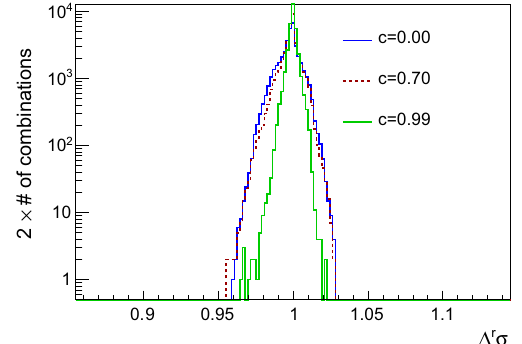
Fig. 4 Difference between the combined result ¯ x obtained with the methodproposedhereandusingadirectlikelihoodcombinationrelative to the total uncertainty on ¯ x , shown for different values of the upper threshold for systematic uncertainties t